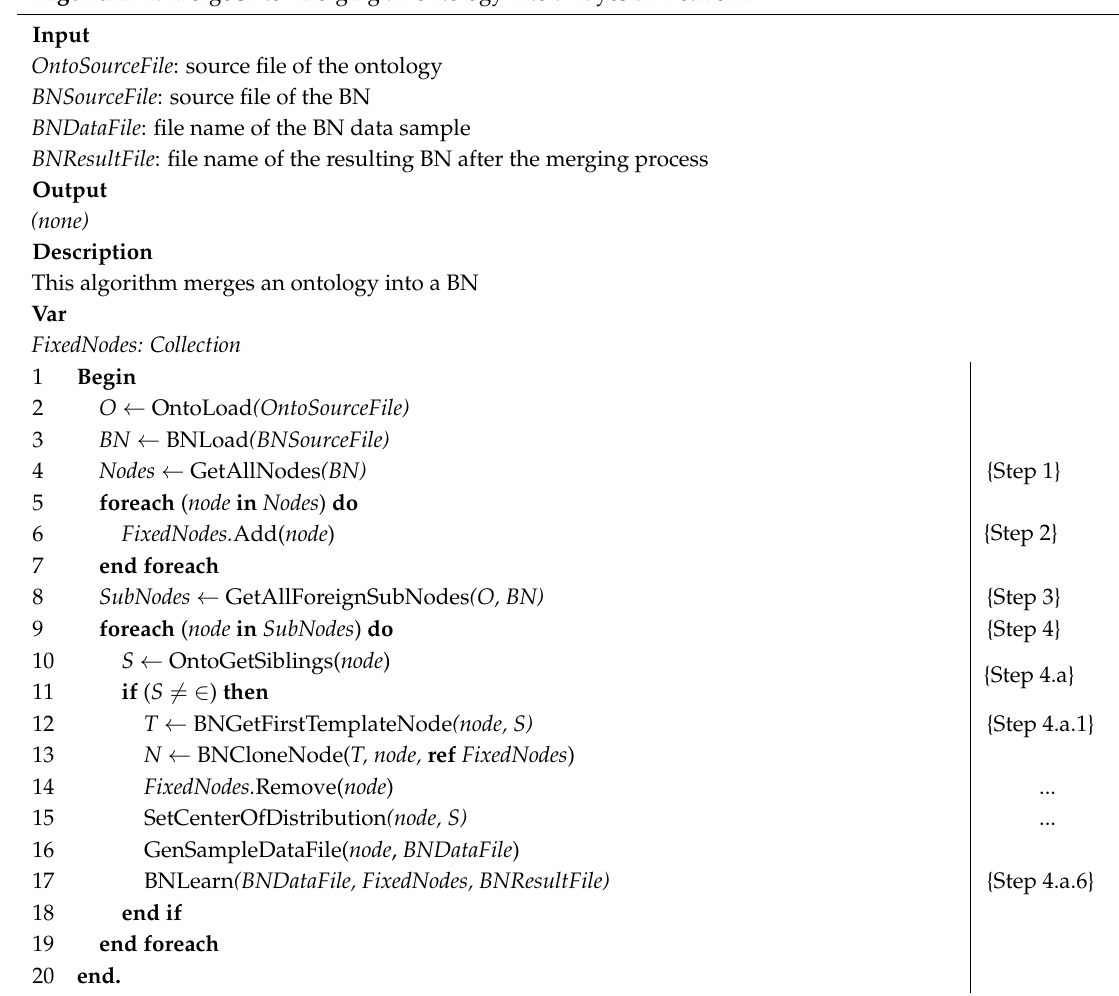
Algorithm 2. MergeOnto: Merging an ontology into a Bayesian